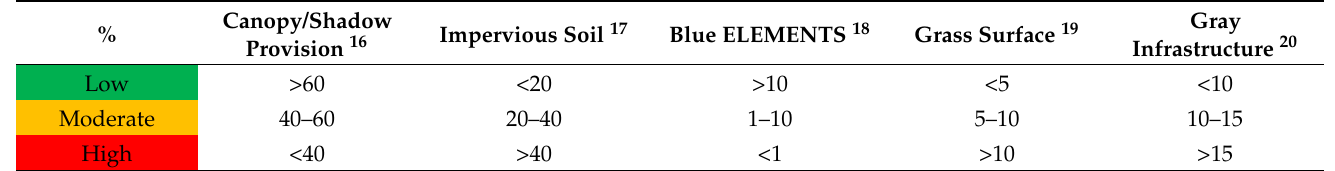
Table 3. Indicators proposed for checking the infrastructure